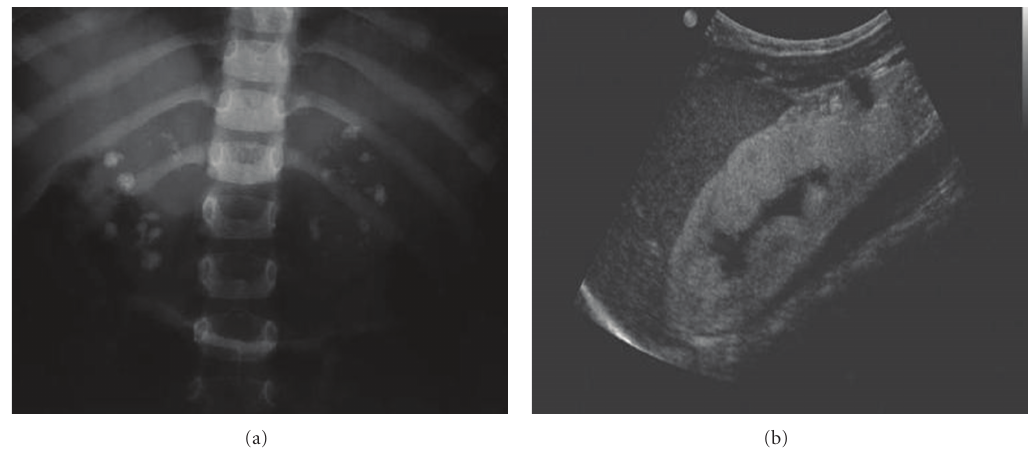
Figure 2: Abdomen X-ray (a) and renal ultrasonography (b) showing urolithiasis and nephrocalcinosis in